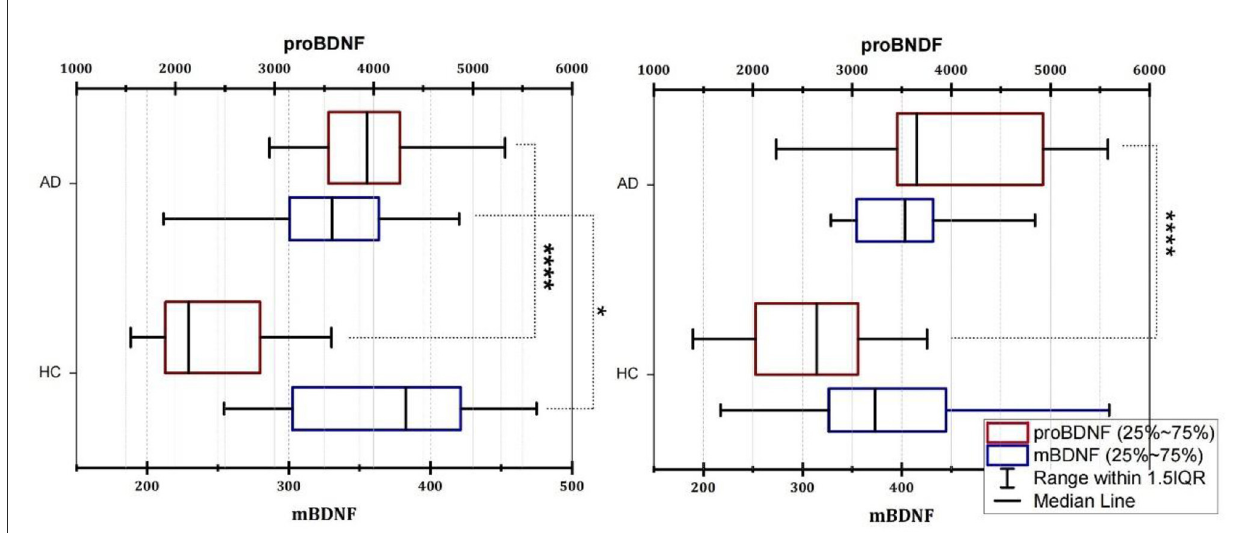
FIGURE1 Box plot of the serum levels of mBDNF and proBDNF (ELISA) in group age 61–70 (Left) and group 71–80 (Right) . AD, Alzheimer’s disease; HC, healthy control; mBDNF, mature brain-derived neurotrophic factor; proBDNF, the precursor of brain-derived neurotrophic factor. The horizontal lines in the middle of the boxes represent the median and interquartile range [IQR] and the data were analyzed using the Mann–Whitney (M-W) U test or t -test. Control, healthy controls; AD, Alzheimer’s disease. Significance was indicated with an *when p < 0.05, and ****when p < 0.0001.